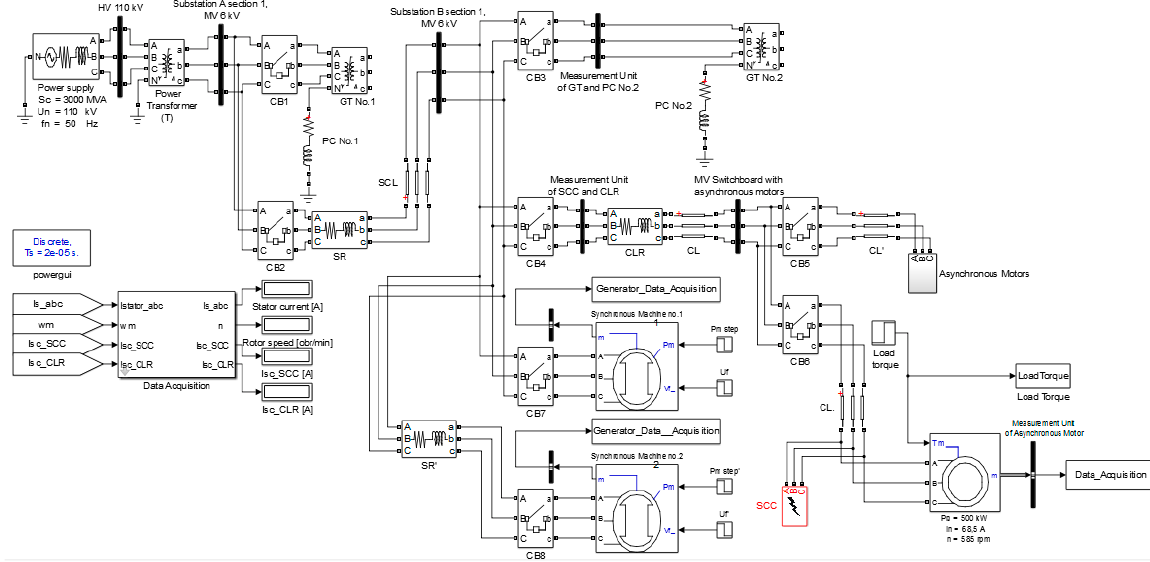
Figure 5. Block diagram of the industrial grid model.